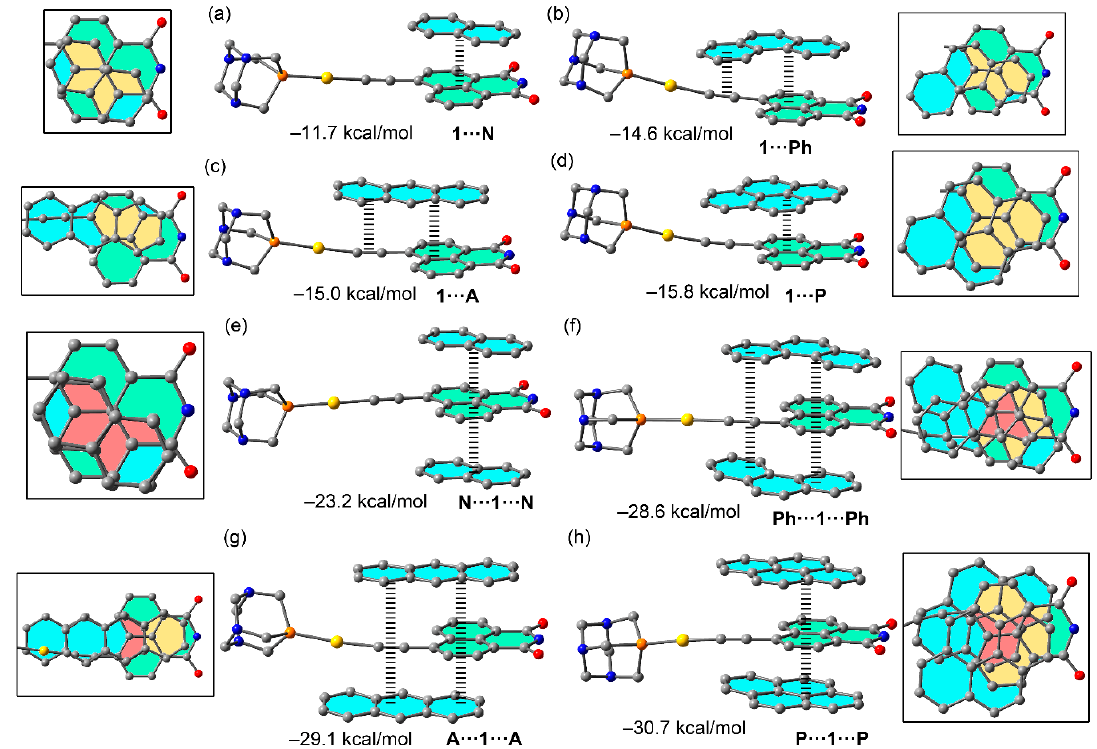
Figure 6. PB86-D3(COSMO)/def2-TZVP optimized geometries and binding energies of the dimers 1···N ( a ), 1···Ph ( b ), 1···A ( c ) 1···P ( d ) and trimers N···1···N ( e ), Ph···1···Ph ( f ), A···1···A ( g ) P···1···P ( h ).